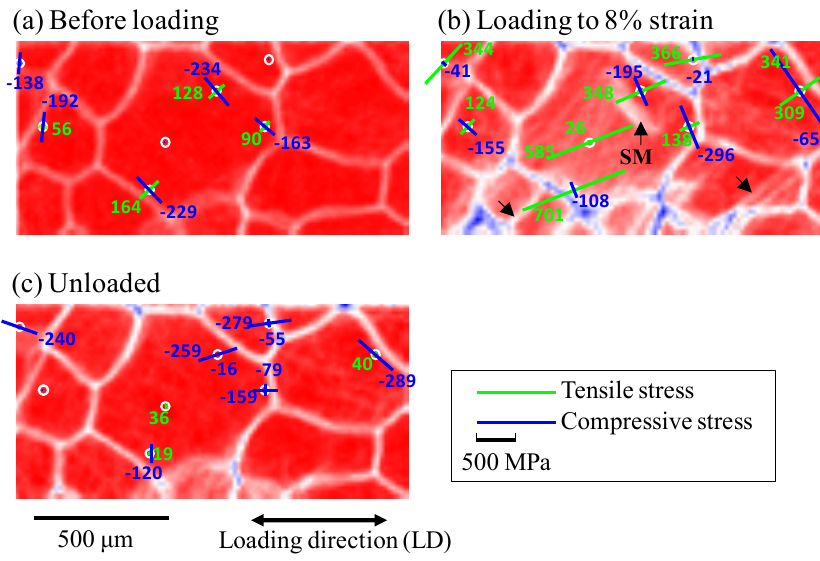
Figure 8. Principal stresses measured at several points ( a ) before loading; ( b ) during loading to 8% strain; and ( c ) after unloading. Arrows in ( b ) indicate stress-induced martensite